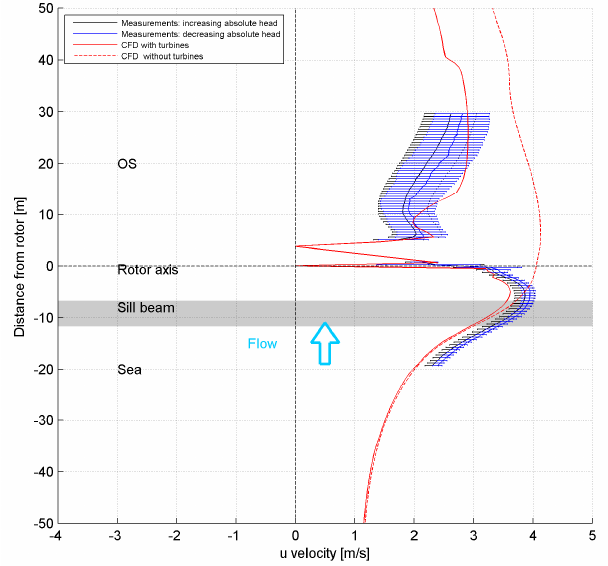
have been well validated against the 2011 measurements